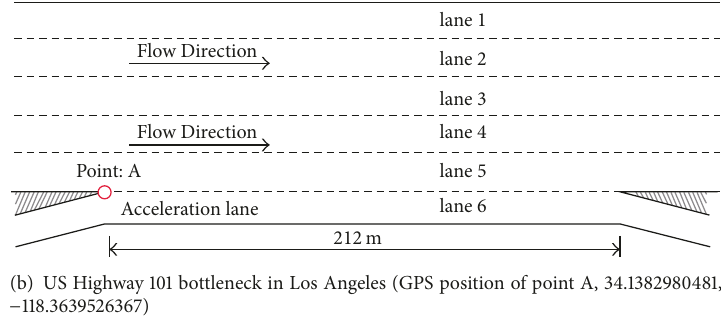
Figure 1: The schematics of two study sites.